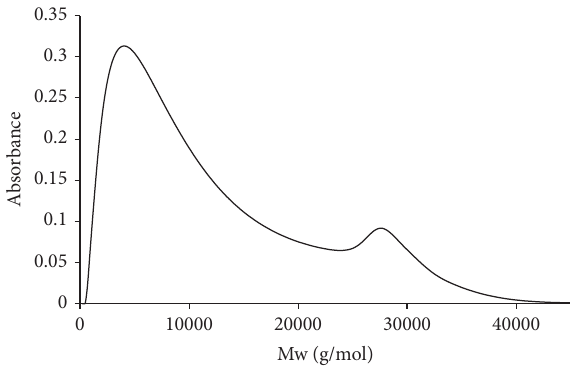
Figure 1: Lignin molecular weight